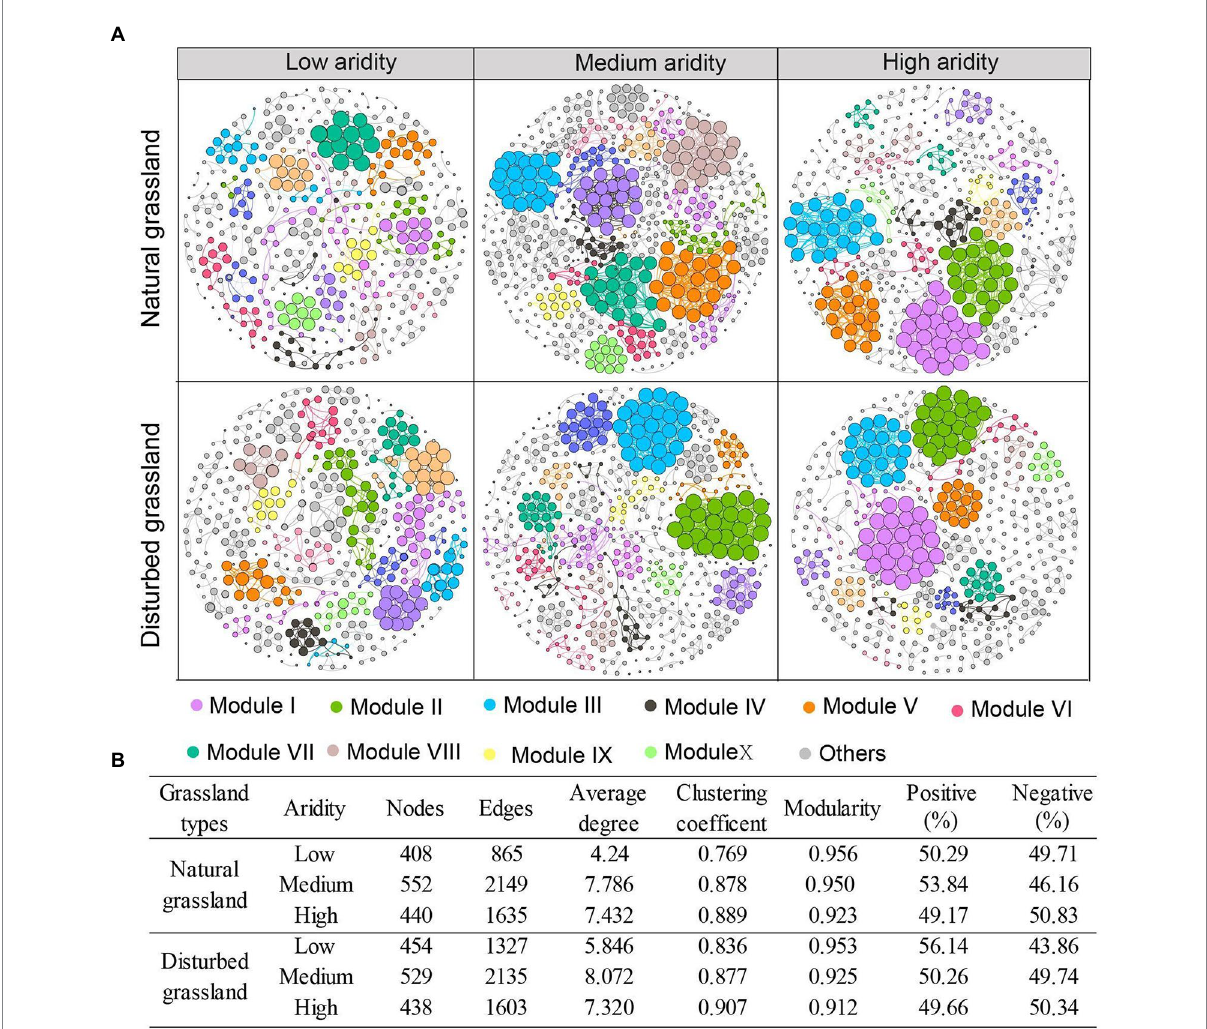
FIGURE 5 Co-occurrence patterns of pqqC community under different aridity levels in natural and disturbed grasslands (A) . Nodes represent individual OTUs; edges represent significant strong and significant Spearman correlations (r > 0.6, p < 0.01). Major modules are shown in different colors, and smaller modules are shown in grey. The size of each node is proportional to the degree. The variations of topological features of networks under different aridity levels in natural and disturbed grasslands (B)